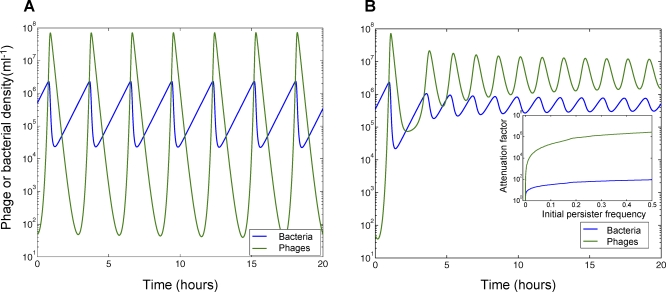
Effect of Persistence on the Dynamics in a Lotka-Volterra Predator–Prey Model(A) Population size without persisters; green: phages; blue: bacteria.(B) Same as (A) but in a population with persisters: the population oscillations are significantly reduced. Inset: reduction in population oscillations as function of the persisters fraction.